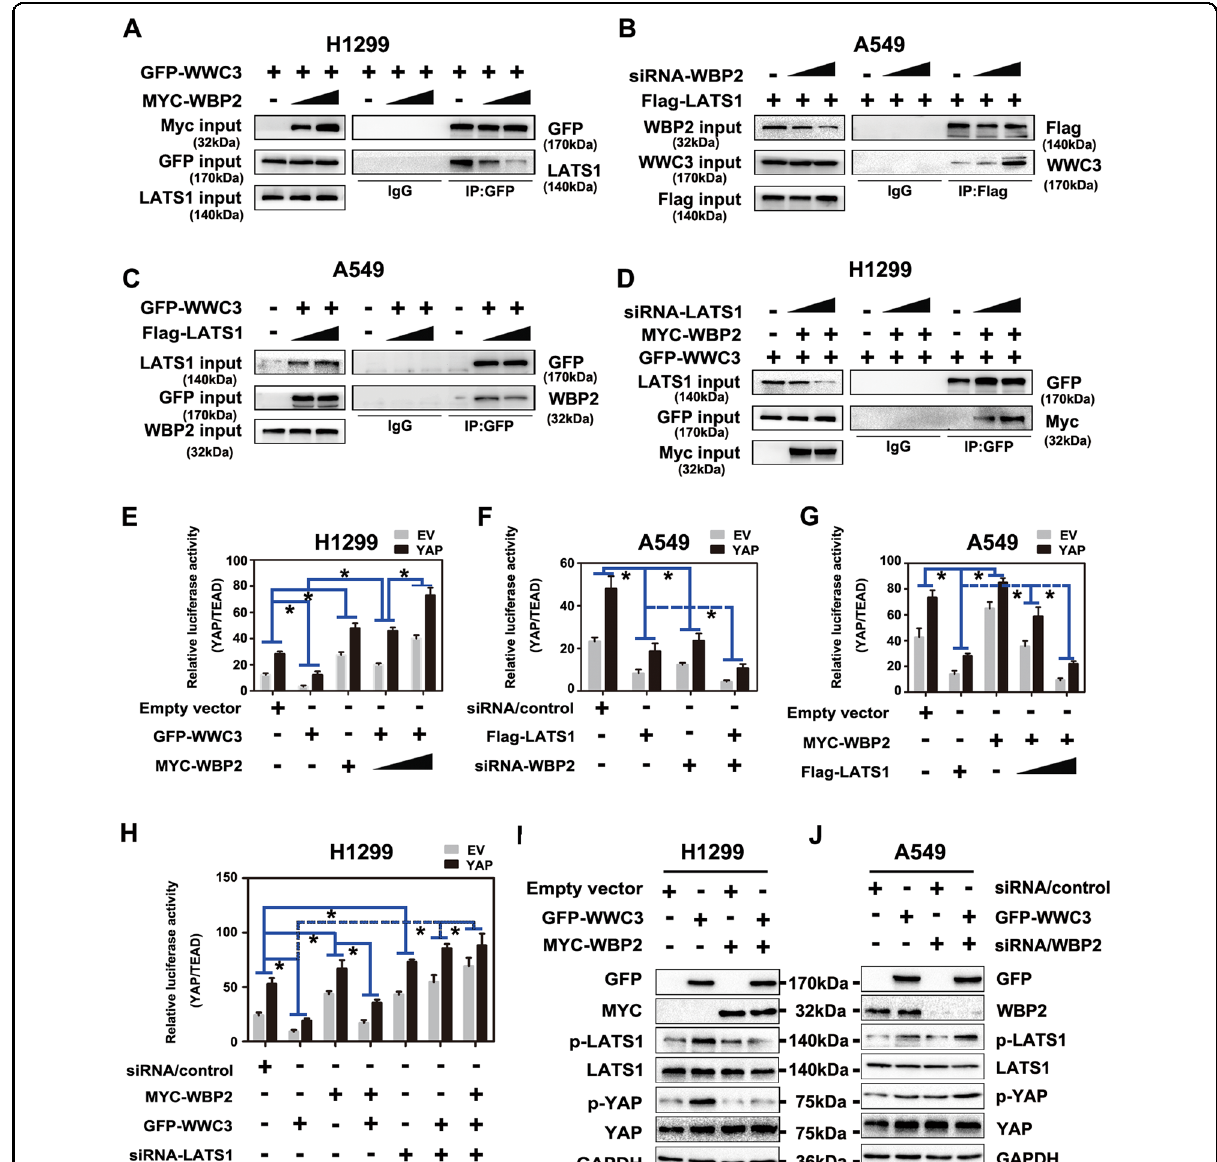
Fig. 6 WBP2 and LATS1 competitively bind to WWC3 to inhibit Hippo pathway activity. A WBP2 overexpression attenuates the binding between WWC3 and LATS1. In the H1299 cell line, the WBP2 plasmid (1 μ g and 2.5 μ g) was transfected in a dose gradient manner. After 48 h, the cells were collected and lysed. A GFP monoclonal antibody was used for immunoprecipitation. The combination change in WWC3 and LATS1 protein in the sediment was detected by western blotting. B The binding of WWC3 to LATS1 increases after WBP2 knockdown. siRNA-WBP2 (5 pmol and 10 pmol) was transfected into A549 cells with high WBP2 expression. After cell collection, binding was detected by anti-FLAG immunoprecipitation followed by anti-WWC3 immunoblotting. C , D Following transfection of LATS1 into A549 cells with low LATS1 expression, the binding of WBP2 to WWC3 gradually decreases with an increase in LATS1 expression ( C ). In contrast, the binding of WBP2 to WWC3 gradually increases with the downregulation of LATS1 after siRNA-LATS1 was transfected into H1299 cells with high LATS1 expression ( D ). E , F Forty-eight hours post-transfection with WBP2 plasmid or siRNA-WBP2 into H1299 cells and A549 cells, the cells were collected and lysed. The results of the dual-luciferase reporter assay reveal that WBP2 overexpression reverses the decrease in TEAD transcriptional activity induced by WWC3 ( E ). Conversely, WBP2 knockdown further enhances the decrease in TEAD transcriptional activity induced by WWC3 ( F ). G , H Similarly, dual-luciferase reporter gene detection assays reveal that LATS1 overexpression reverses the WBP2-induced increase in TEAD transcriptional activity ( G ). Moreover, silencing of LATS1 further enhances the WBP2-induced increase in TEAD transcriptional activity ( H ). I , J Western blot analysis indicates that overexpression of WBP2 reverses the increase in LATS1 and YAP phosphorylation levels induced by WWC3 ( I ). Conversely, knockdown of WBP2 further increases the phosphorylation levels of LATS1 and YAP ( J ). P < 0.05 indicates statistical signi fi cance, * P <